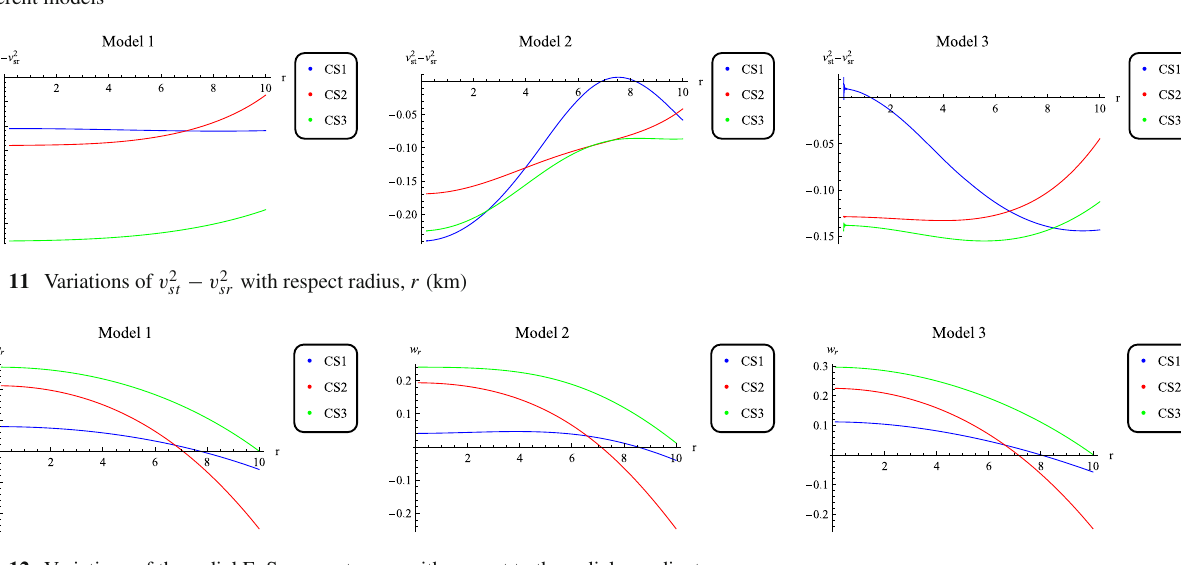
Fig. 10 The plot of gravitational force ( F g ), hydrostatic force ( F h ) and anisotropic force ( F a ) with respect to the radial coordinate r(km) and three different models